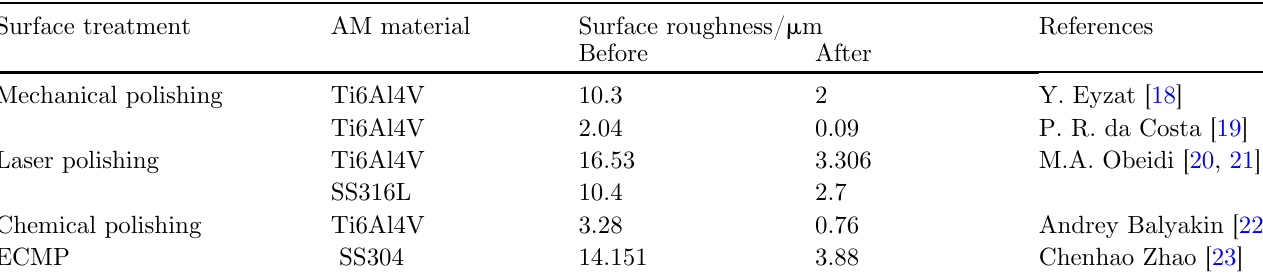
Table 1. AM surface polishing